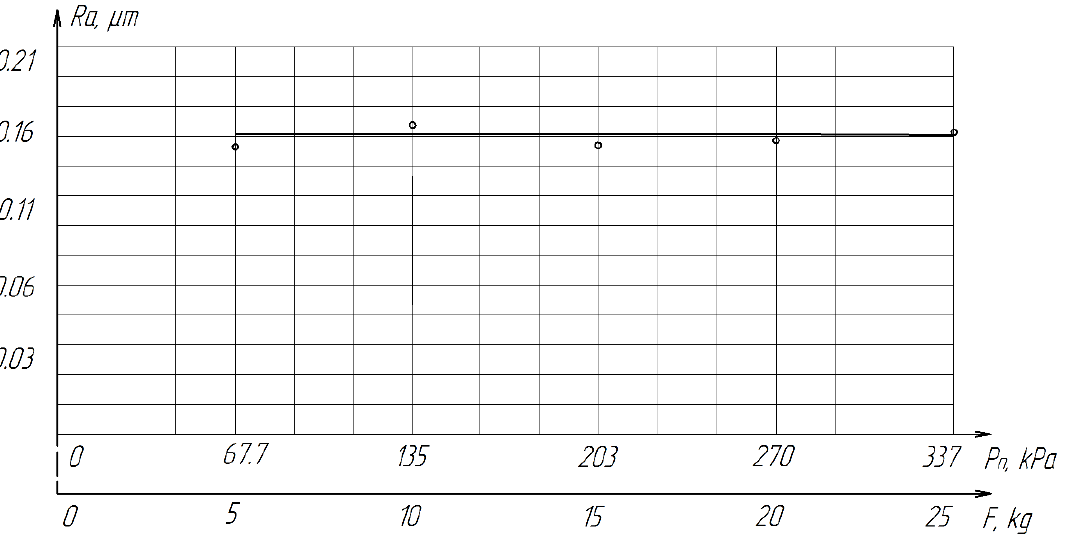
Thus, it was found that the optimal pressure value for processing samples from ZrO 2